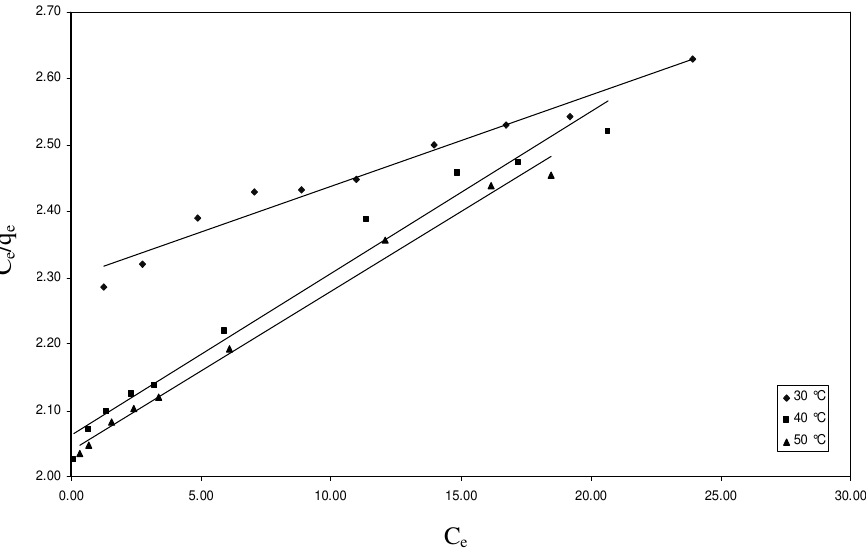
Figure 7. Langmuir plot-temperature